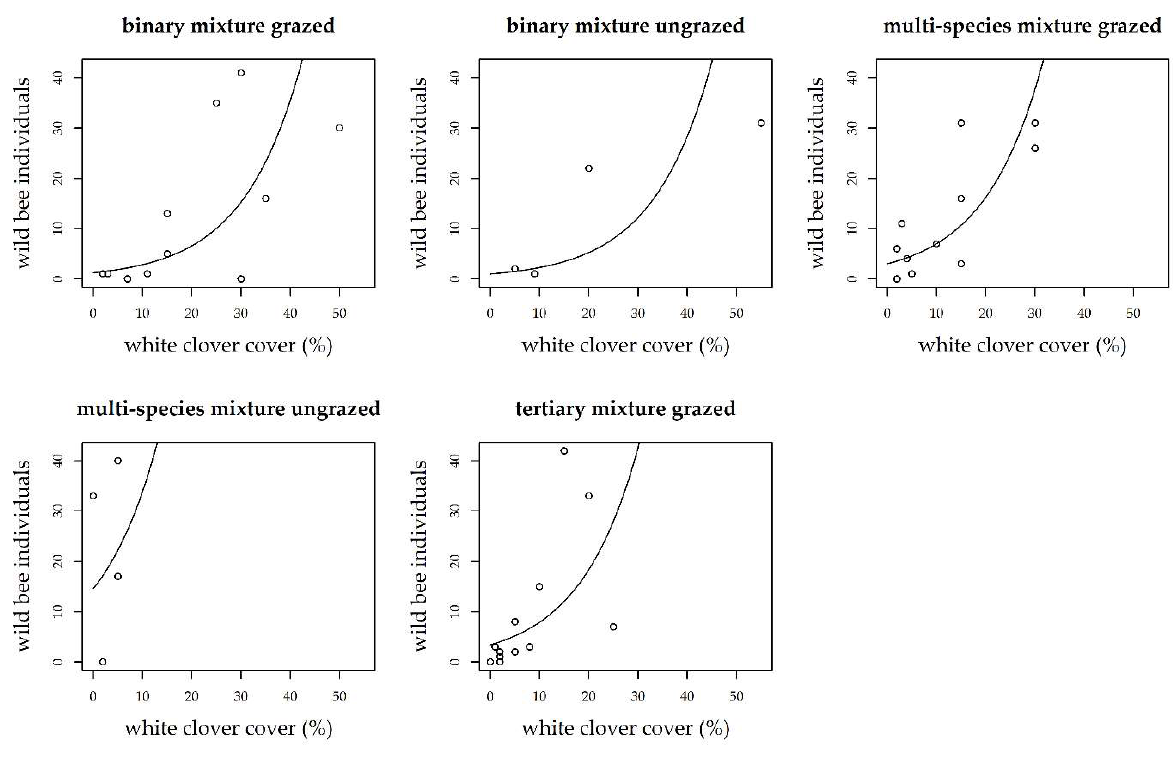
Figure 1. Effect of white clover flower cover on wild bee abundance on the mixtures and manage- ments.